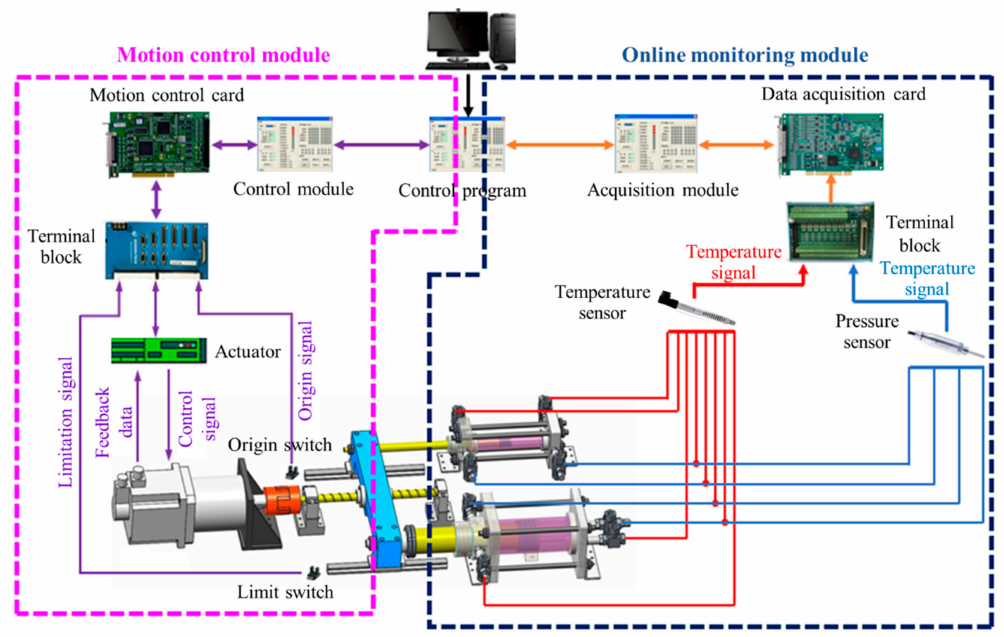
Figure 9. The control system of the developed compressor